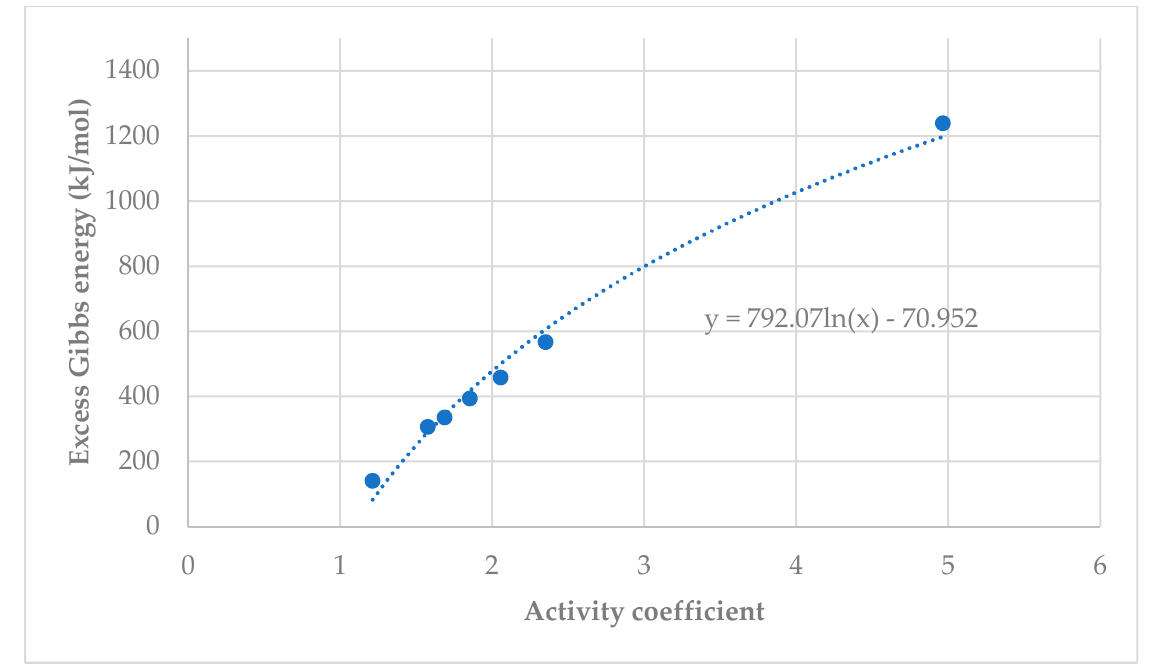
Figure 12. Excess Gibbs Energy vs. activity coefficient for xylitol ( a ) and fructose ( b ) .